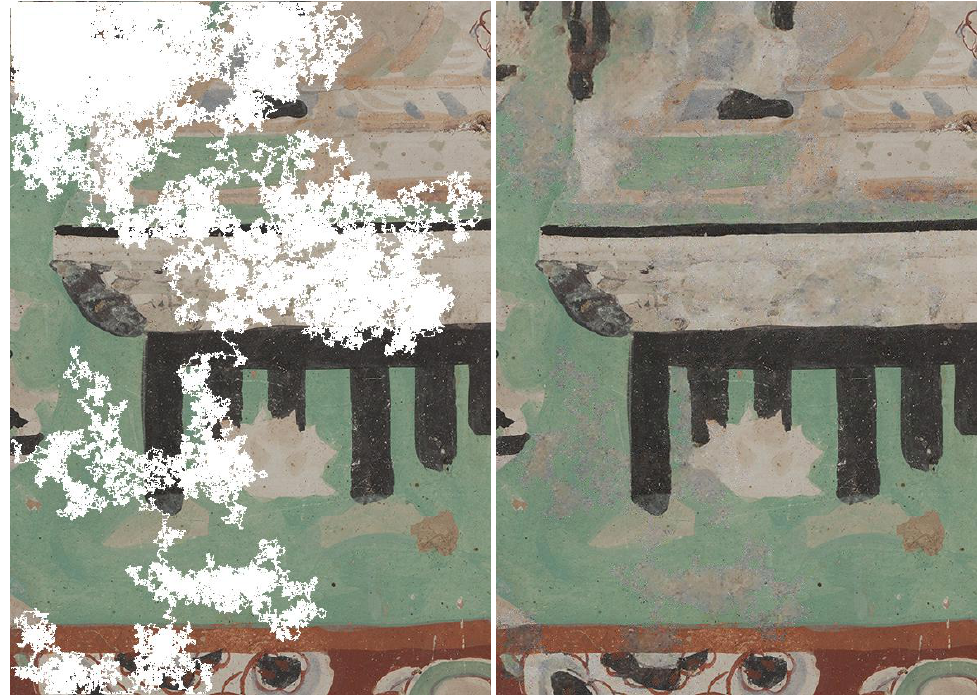
Figure 10. Inpainting result for Figure 6d. The beige structure in the middle of the image remains color coherent in the infilled image. Similarly, the two leftward black poles. However, the reconstruction is more blurry in the top left corner, which corresponds to a bigger and more contiguous